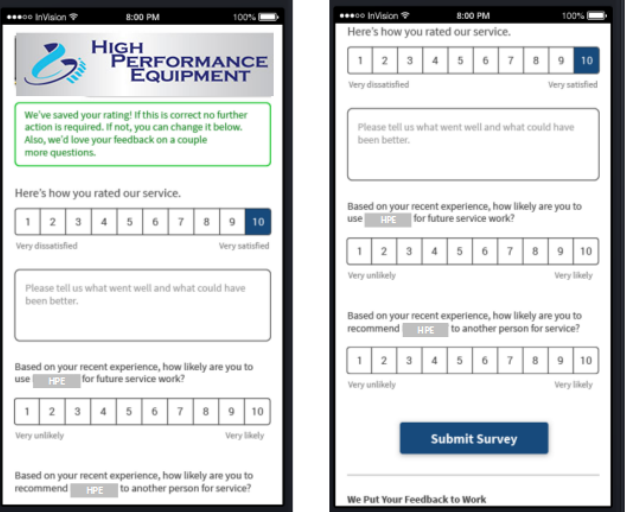
Figure 4. The new format of a short mobile-based customer survey with mostly open-ended